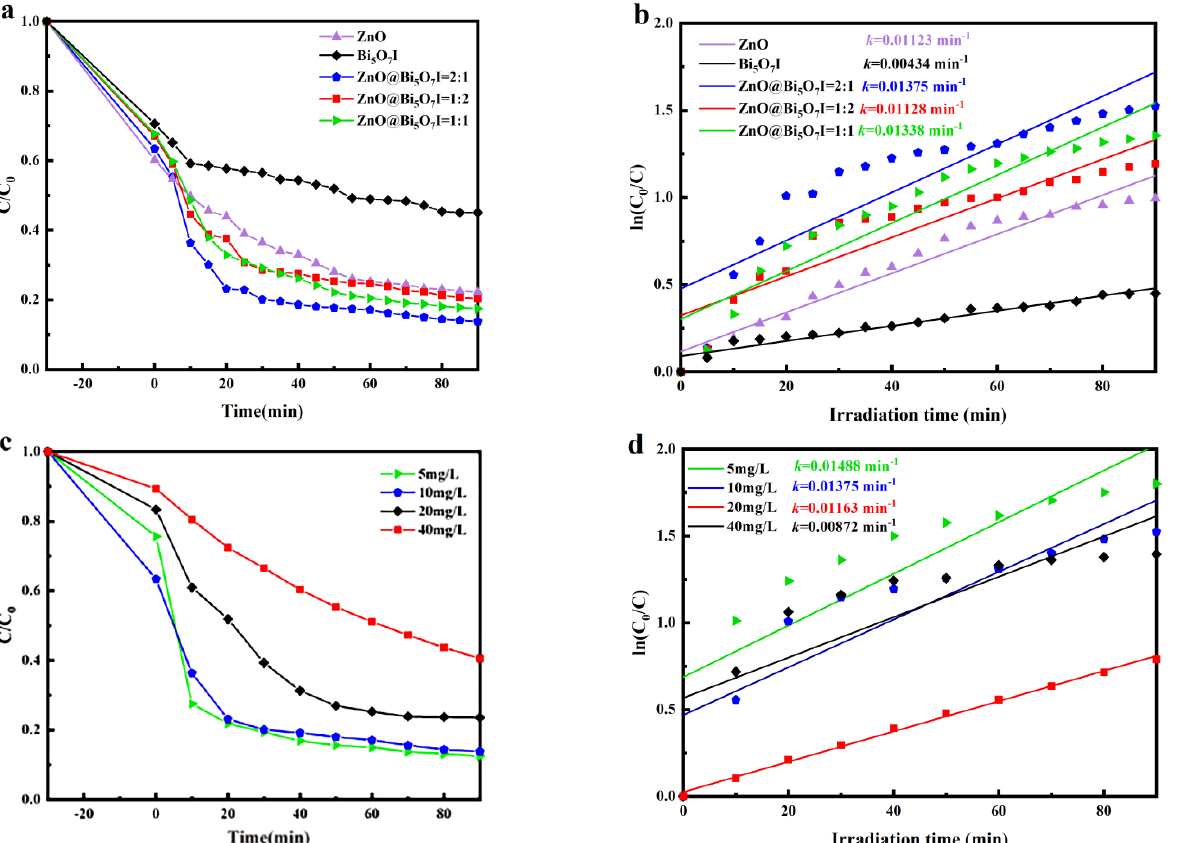
Figure 6. ( a , b ) ZnO@Bi 5 O 7 I samples at different ratios in TC 10 mg/L, and ( c , d ) photocatalytic degradation rates of TC in ZnO@Bi 5 O 7 I (2:1) with differing concentrations.